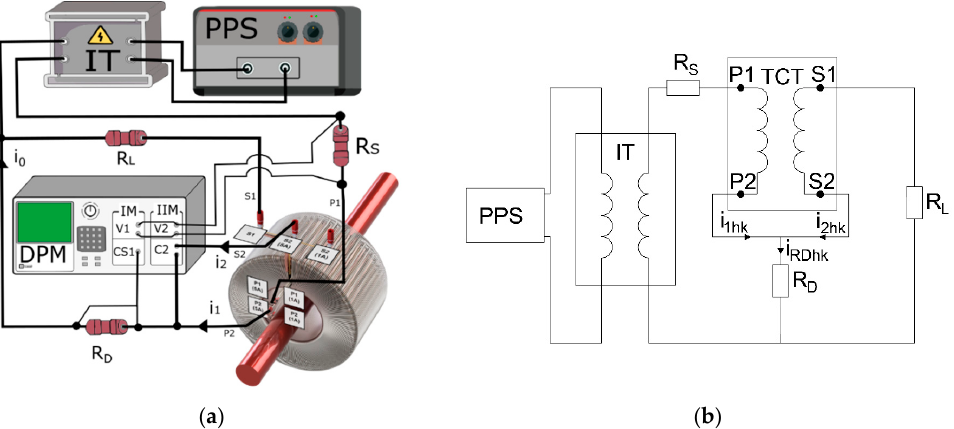
Figure 2. ( a ) Measuring circuit used to determine the values of current and phase errors of higher harmonics transformation in the condition of equivalent ampere-turns, ( b ) simplified wiring diagram.